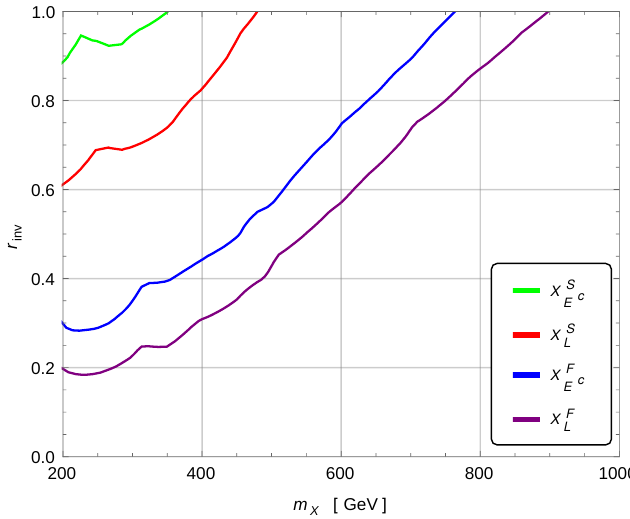
Figure 3. Limits at 95% CLs on mediators of category II that communicate only with the (cid:12)rst generation for large r inv . Bounds are obtained by recasting the slepton search of ref. [46]. The Hidden Valley group G is taken to be SU(3). The excluded regions are left of the